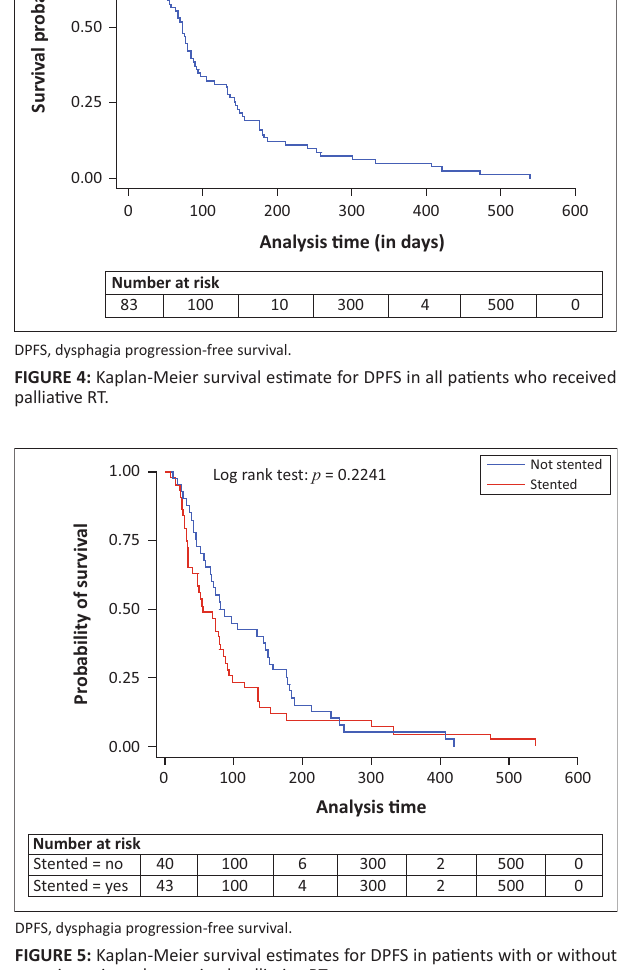
TABLE 3: Simple linear regression analysis for variables associated with dysphagia progression-free survival. Variable Simple linear regression analysis Beta coeff.